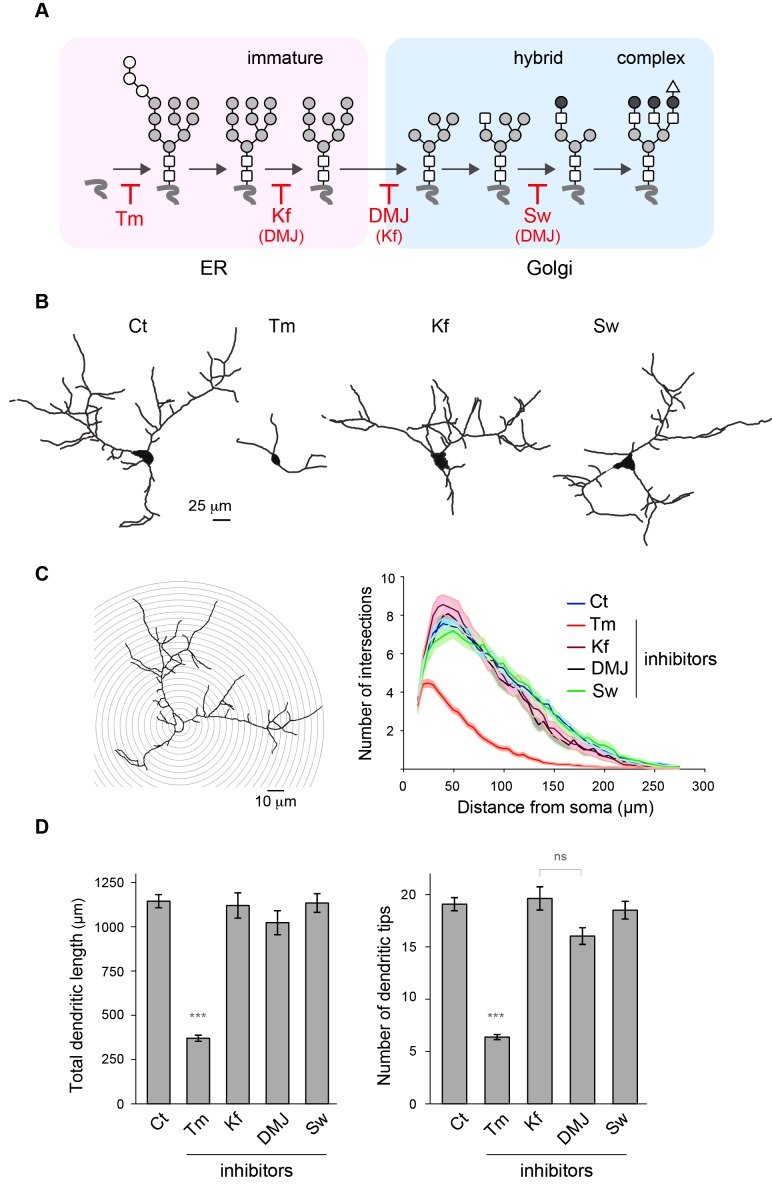
Mature N-glycans are not required for normal dendritic development.(A) Simplified representation of the N-glycosylation pathway and site of action of the glycosylation inhibitors tunicamycin (Tm), kifunensine (Kf), 1-deoxymannojirimycin (DMJ) and swainsonine (Sw). (B–C) Camera lucida drawings (B) and/or Sholl analysis (C) of the dendrites of hippocampal neurons (DIV 11) after a three day exposure to vehicle (DMSO, Ct), Tm (1.2 µM), Kf (5 μM), DMJ (75 μM) or Sw (88 μM). (D) Total dendritic length (left panel) and branch tip numbers (right panel) in neurons treated with vehicle (Ct), Tm, Kf, DMJ or SW. Mean ± SEM. N=31 to 137 cells in 2–6 independent experiments. ***p<1x10−4; Kruskal-Wallis/Dunn’s multiple comparison test. In B–D, note that while Tm strongly impairs dendritic growth and branching, blocking the maturation of N-glycans in the ER or the GA has no detectable effect on dendritic development.